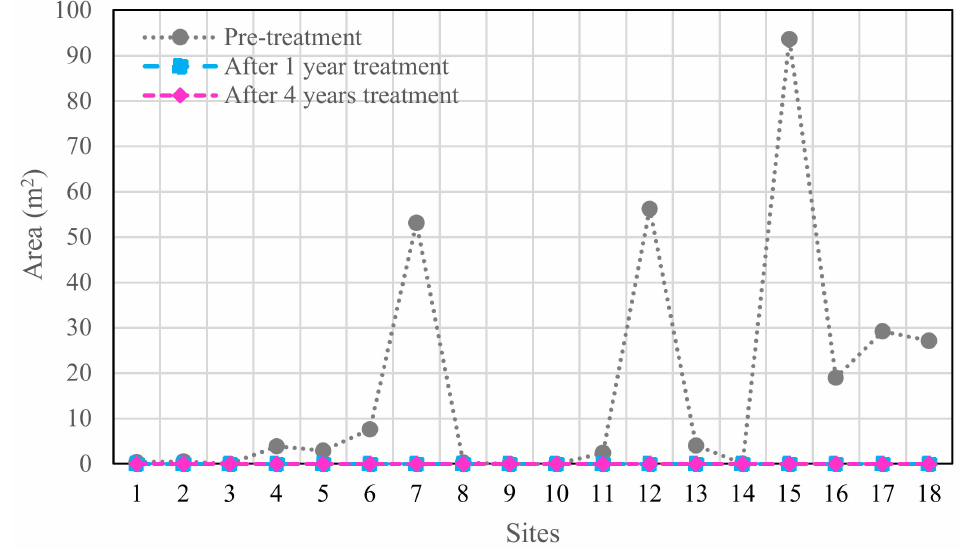
Figure 10. Effectiveness of WMA overlay containing RAP on alligator cracking under dry climatic conditions.